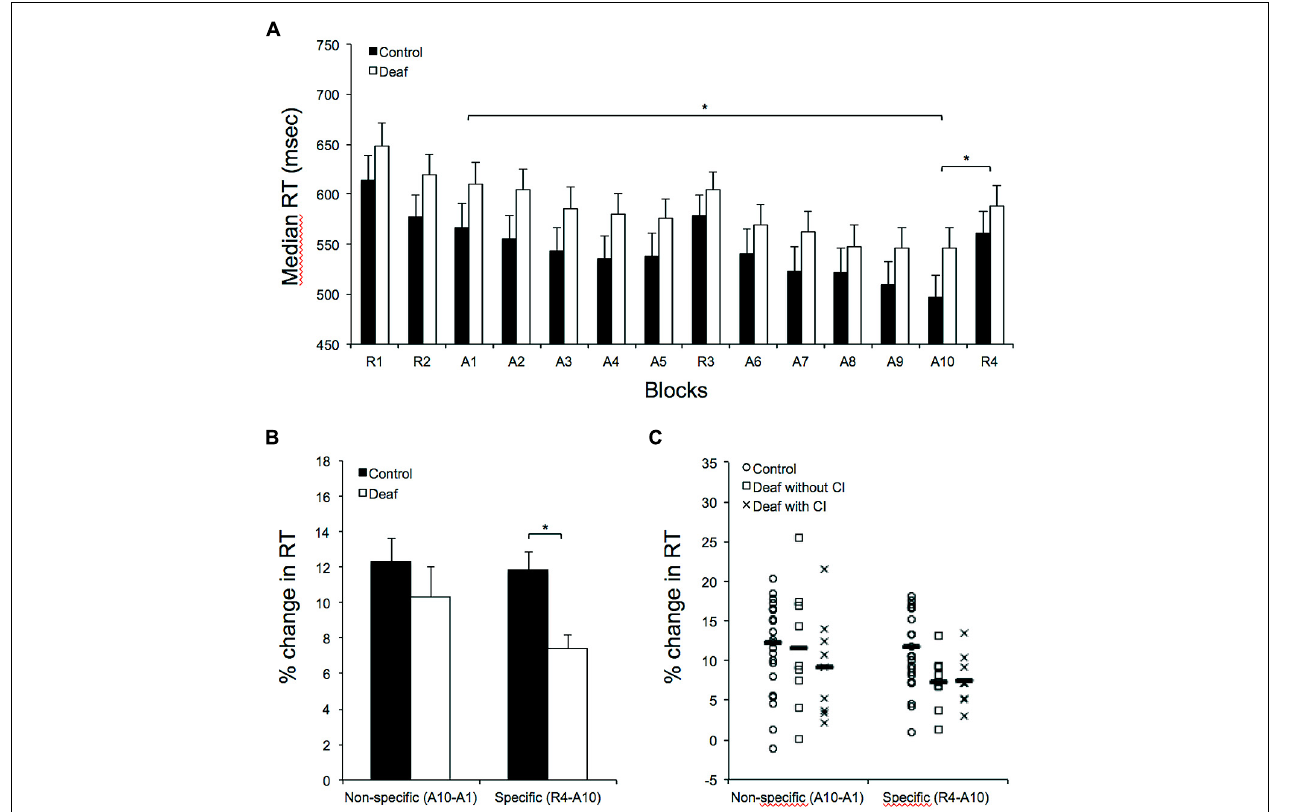
percent change) in control relative to the deaf after 10 training blocks (A1 vs. A10). The histogram, however, illustrates the significantly greater sequence-specific RT increase (in percent change) from the last training block (A10) to the immediately following random block (R4) in control relative to the deaf Individuals. (C) Individual results of the control and the deaf with or without a cochlear implant (CI). Group averages are shown with horizontal bars. (*) Corresponds to P <